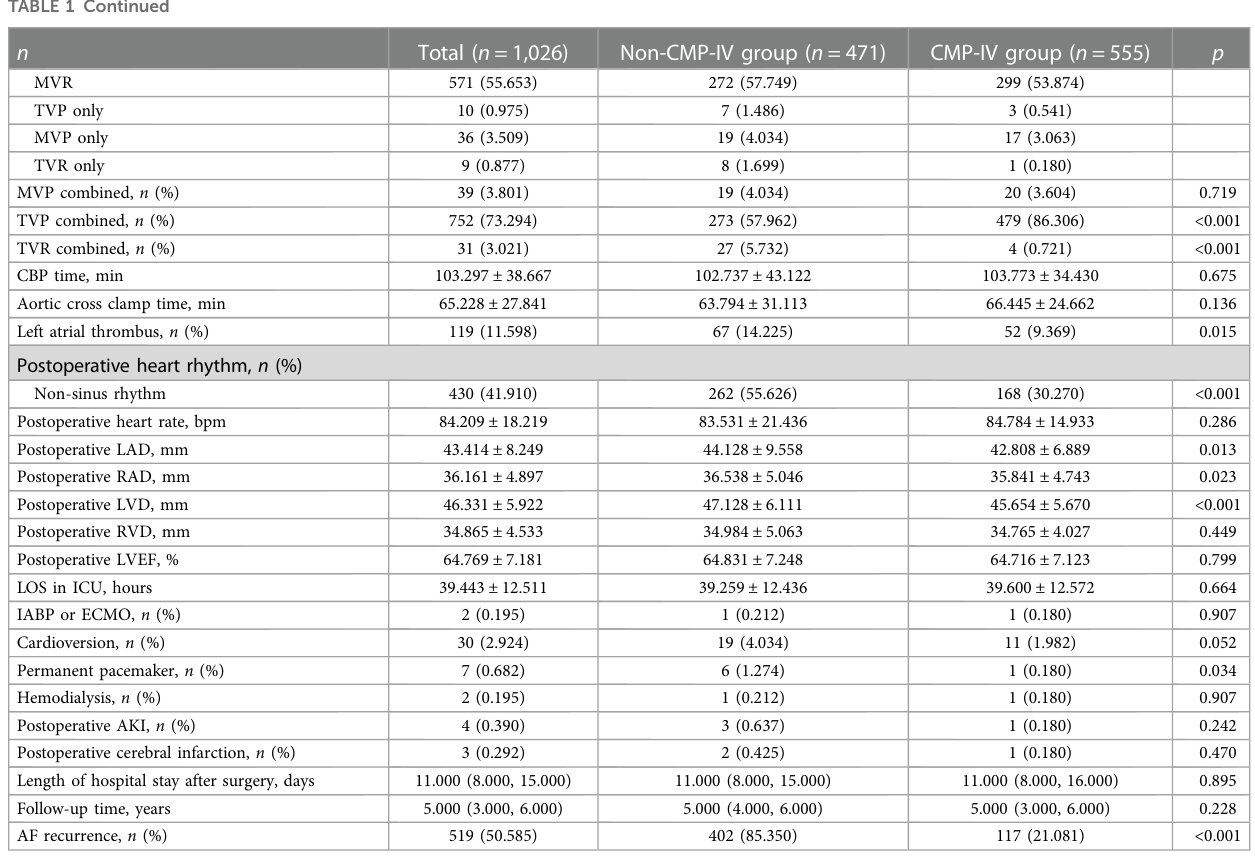
Figure 2 . Based on the ROC curves and the model evaluation results, we found that the CatBoost, LightGBM, XGBoost, and RF models in the CMP-IV group had the highest AUC of 0.768 (95% CI:0.742, 0.786), 0.766 (95% CI:0.744, 0.792), 0.762 (95% CI:0.723, 0.801), 0.732 (95% CI:0.701, 0.763), respectively. LightGBM, XGBoost, RF, and CatBoost models performed the best (as shown in Table 3 ), with AUC of 0.714 (95% CI: 0.699, 0.813), 0.712 (95% CI: 0.669, 0.836), 0.711 (95% CI: 0.666, 0.849), and 0.699 (95% CI: 0.669, 0.831), respectively. Other